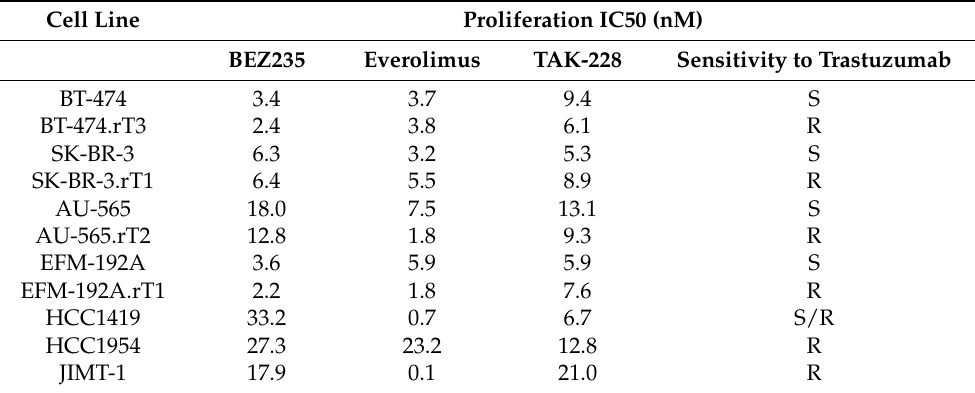
Table 1. Inhibitory concentrations of mTOR inhibitors as a measure of proliferation inhibition in a panel of breast cancer cell